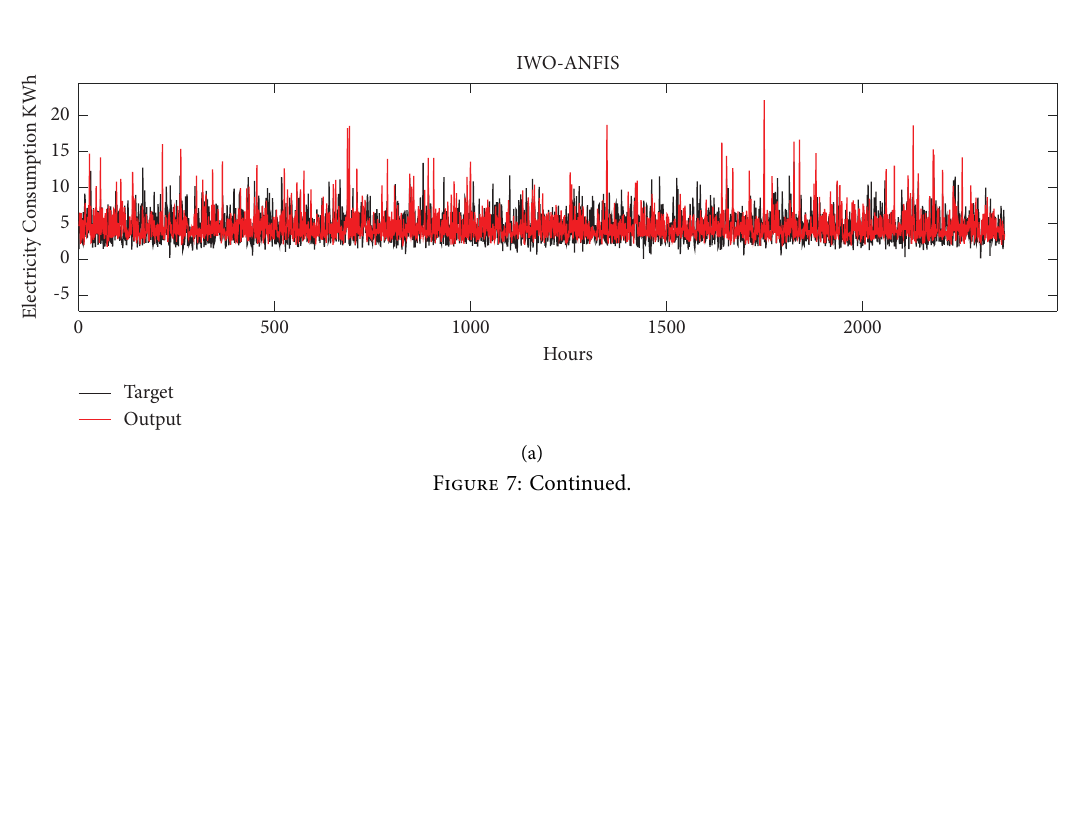
Figure 6: Plot of TLBO-ANFIS